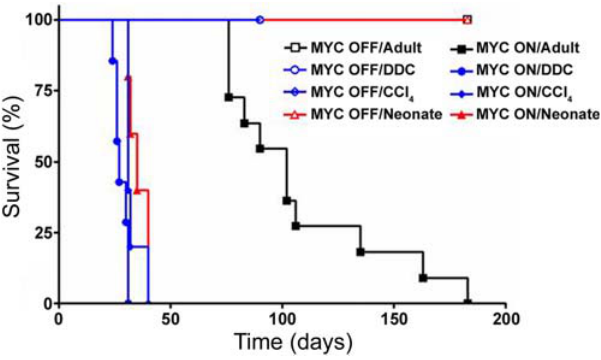
Figure 2. DDC and CCl 4 Cooperate with MYC to Induce Accelerated Liver Tumorigenesis. Shown are Kaplan-Meier survival curves for 6–8 w adult mice that overexpressed MYC and were simultaneously treated with: nothing (filled black square), DDC (filled blue circle), or CCl 4 (filled blue diamond). Adult mice treated with hepatotoxins in the absence of MYC overexpression (MYC OFF) are displayed with the corresponding open shape: nothing (empty black square), with DDC (empty blue circle), or CCl 4 (empty blue diamond). Also shown are survival curves of neonatal mice in which MYC was either overexpressed (filled red triangle), or remained inactive (empty red triangle) starting at birth. Cohorts consisted of 5–10 mice. MYC transgene expression was activated by removal of doxycycline from the mouse drinking water on the day of hepatotoxin treatment initiation. Mice were sacrificed when moribund with tumor